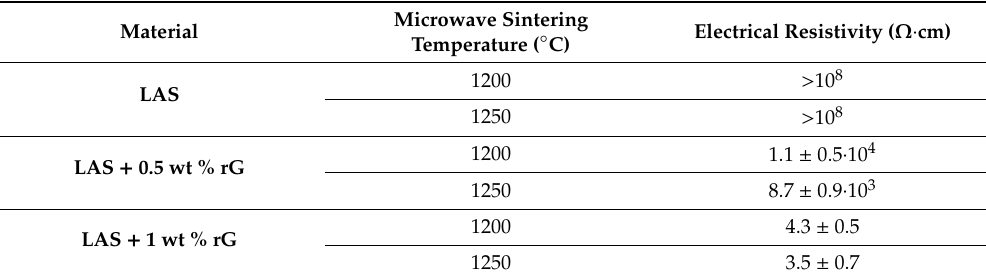
Table 1. Electrical characterization of LAS and LAS-rG materials.